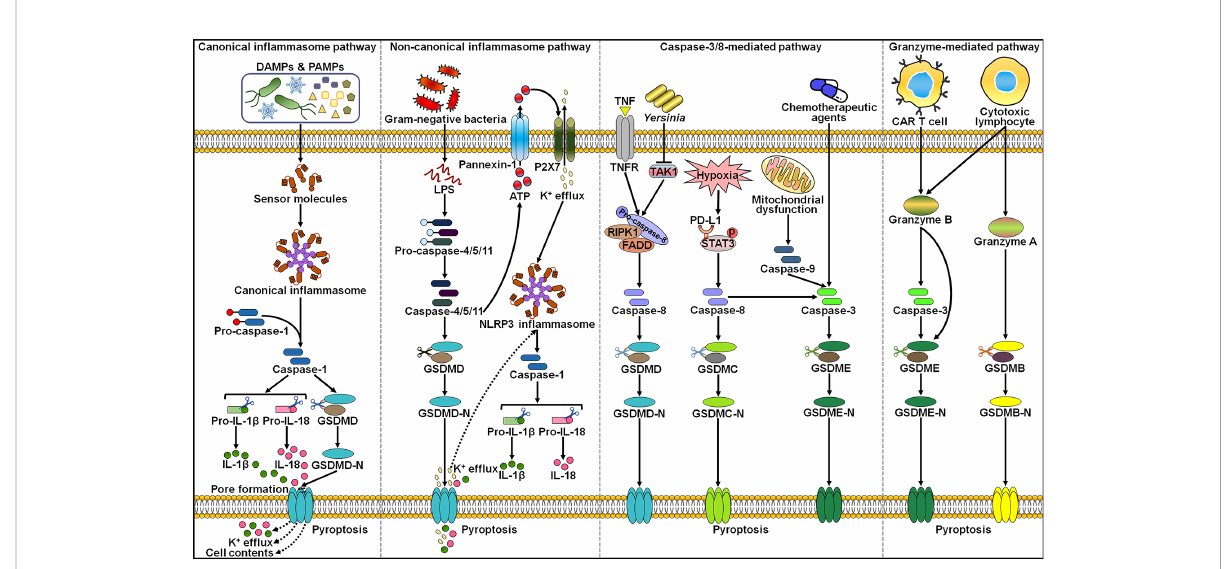
FIGURE 1 The main molecular mechanisms of pyroptosis. In the canonical in fl ammasome pathway, cellular signals (e.g. DAMPs and PAMPs) can activate the canonical in fl ammasome and capase-1. Active caspase-1 cleaves GSDMD to unleash its N-terminal domain (GSDMD-N), which perforates the cell membrane by forming oligomeric pores. These events lead to the loss of membrane integrity and cell lysis. In addition, caspase-1 cleaves pro-IL-1 b and pro-IL-18 into their mature forms, which are released into the extarcellular milieu through the GSDMD-N pore. In the non-canoncial in fl ammasome pathway, cytosolic LPS from invading Gram-negative bacteria directly activates in fl ammatory caspase-4/5/11, thus evoking GSDMD-mediated pyroptosis. The GSDMD-N pore causes the ef fl ux of potassium (K + ), eventually inducing the assembly of NLRP3 in fl ammasome and caspase-1-dependent IL-1 b and IL-18 secretion. In addition, acitve caspase-11 induces the opening of the pannexin-1 channel, and thus tiggers the extracellular release of ATP, which activates NLRP3 in fl ammasome via the P2X7 receptor. In caspase-8-mediated pathway, the pathogenic Yersinia infection results in inhibition of the TAK1 activity, motivating the RIPK1/caspase-8 pathway. Active caspase-8 cleaves GSDMD to produce GSDMD-N, resulting in pyroptotic cell death. Under hypoxia conditions, p-STAT3 physically binds to PD-L1 and favors its nuclear translocation, where PD-L1 enhances GSDMC gene expression. TNF- a -activated caspase-8 speci fi cally shears GSDMC, liberating its N-terminal domain (GSDMC-N) that punches holes in the cell membrane and triggers pyroptosis. In capase-3-mediated pathway, chemotherapeutic agent-activated caspase-3 converts GSDME into GSDME-N, which perforates the cell membrane to initiate pyroptosis. In the granzyme-mediated pathway, CAR T cells prompt caspase-3/GSDME-dependent pyroptosis in target cells by secreting granzyme